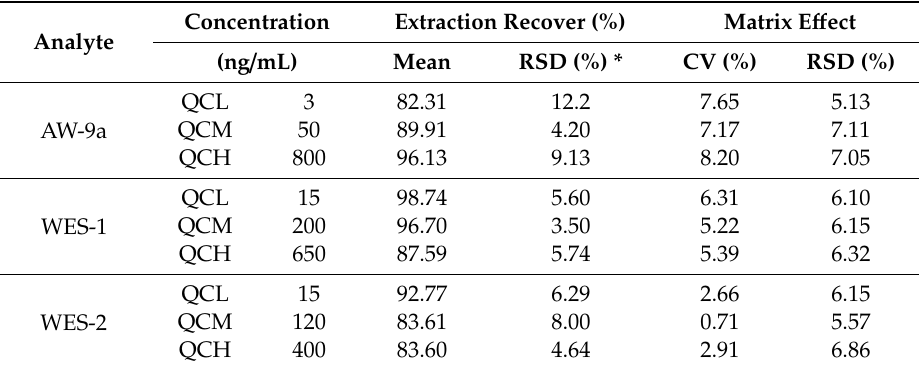
Table 3. Matrix e ff ects for AW-9a, WES-1, and WES-2 in human plasma. Concentration Extraction Recover (%) Matrix E ff Analyte